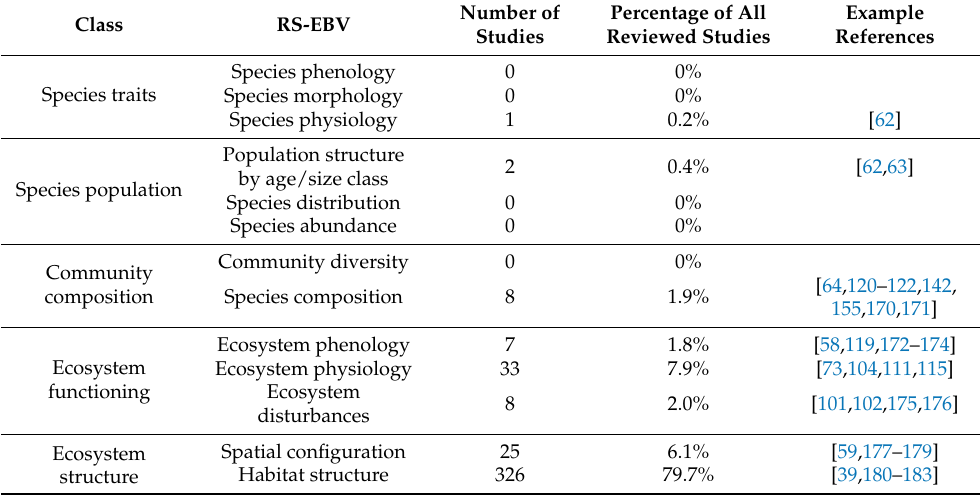
Table 3. Number and percentage of reviewed studies by remote sensing essential biodiversity variable (RS-EBV) as defined by [18]. The total number of studies exceeds 351 because some studies mentioned several